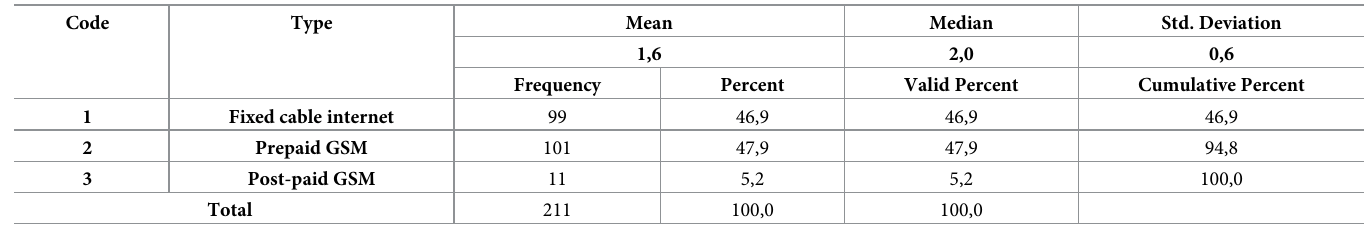
Table 7. Network type.